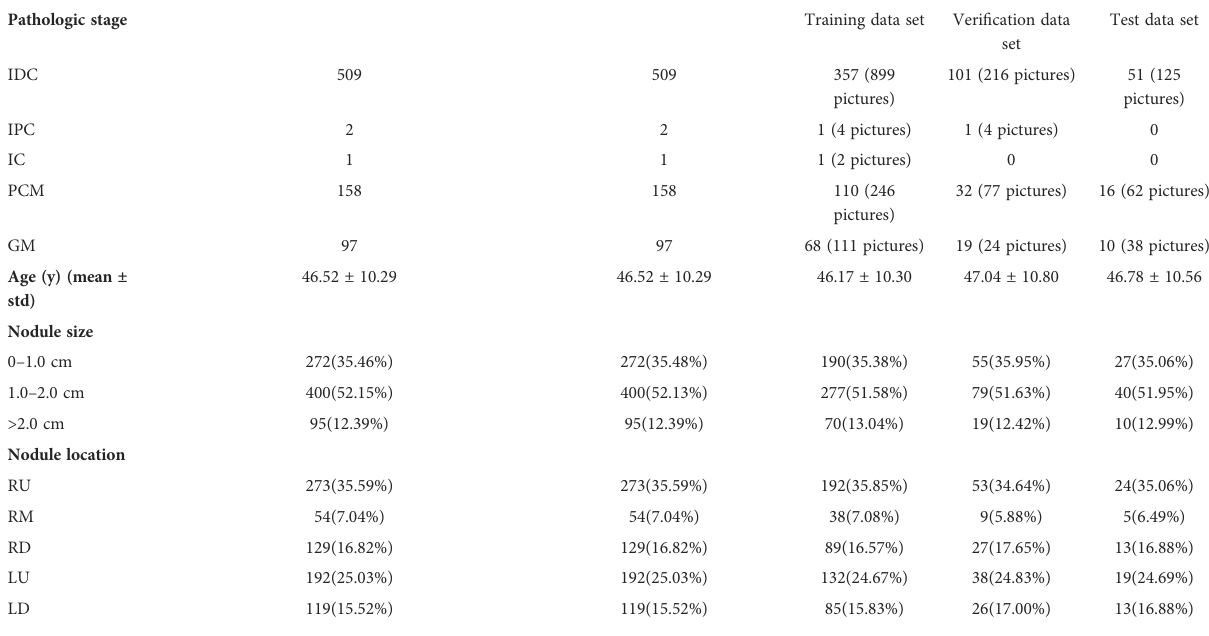
TABLE 1 The baseline of the patients included in the data set.